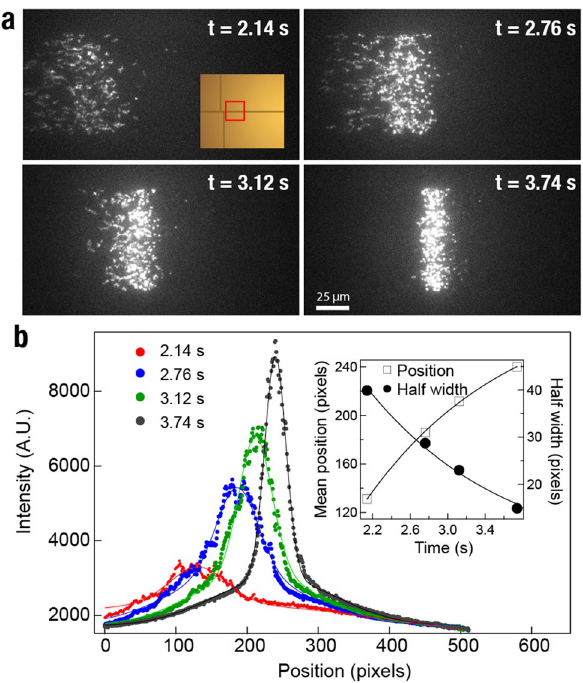
Figure 3. Protein self-stacking at the gel interface. ( a ) Atto647N-labeled BSA proteins are driven towards the polyacrylamide gel (exposed at 12,500 mJ/cm 2 ) at a 30 V applied bias. Inlet shows the position on the chip. ( b ) The initial plug with an end-to-end length of ~ 200 µm is concentrated to a width of ~ 8 µm at the gel interface by t = 3.74 s and fitted by Gaussian distributions. Inlet shows the mean position of the fitting and half-width as a function of